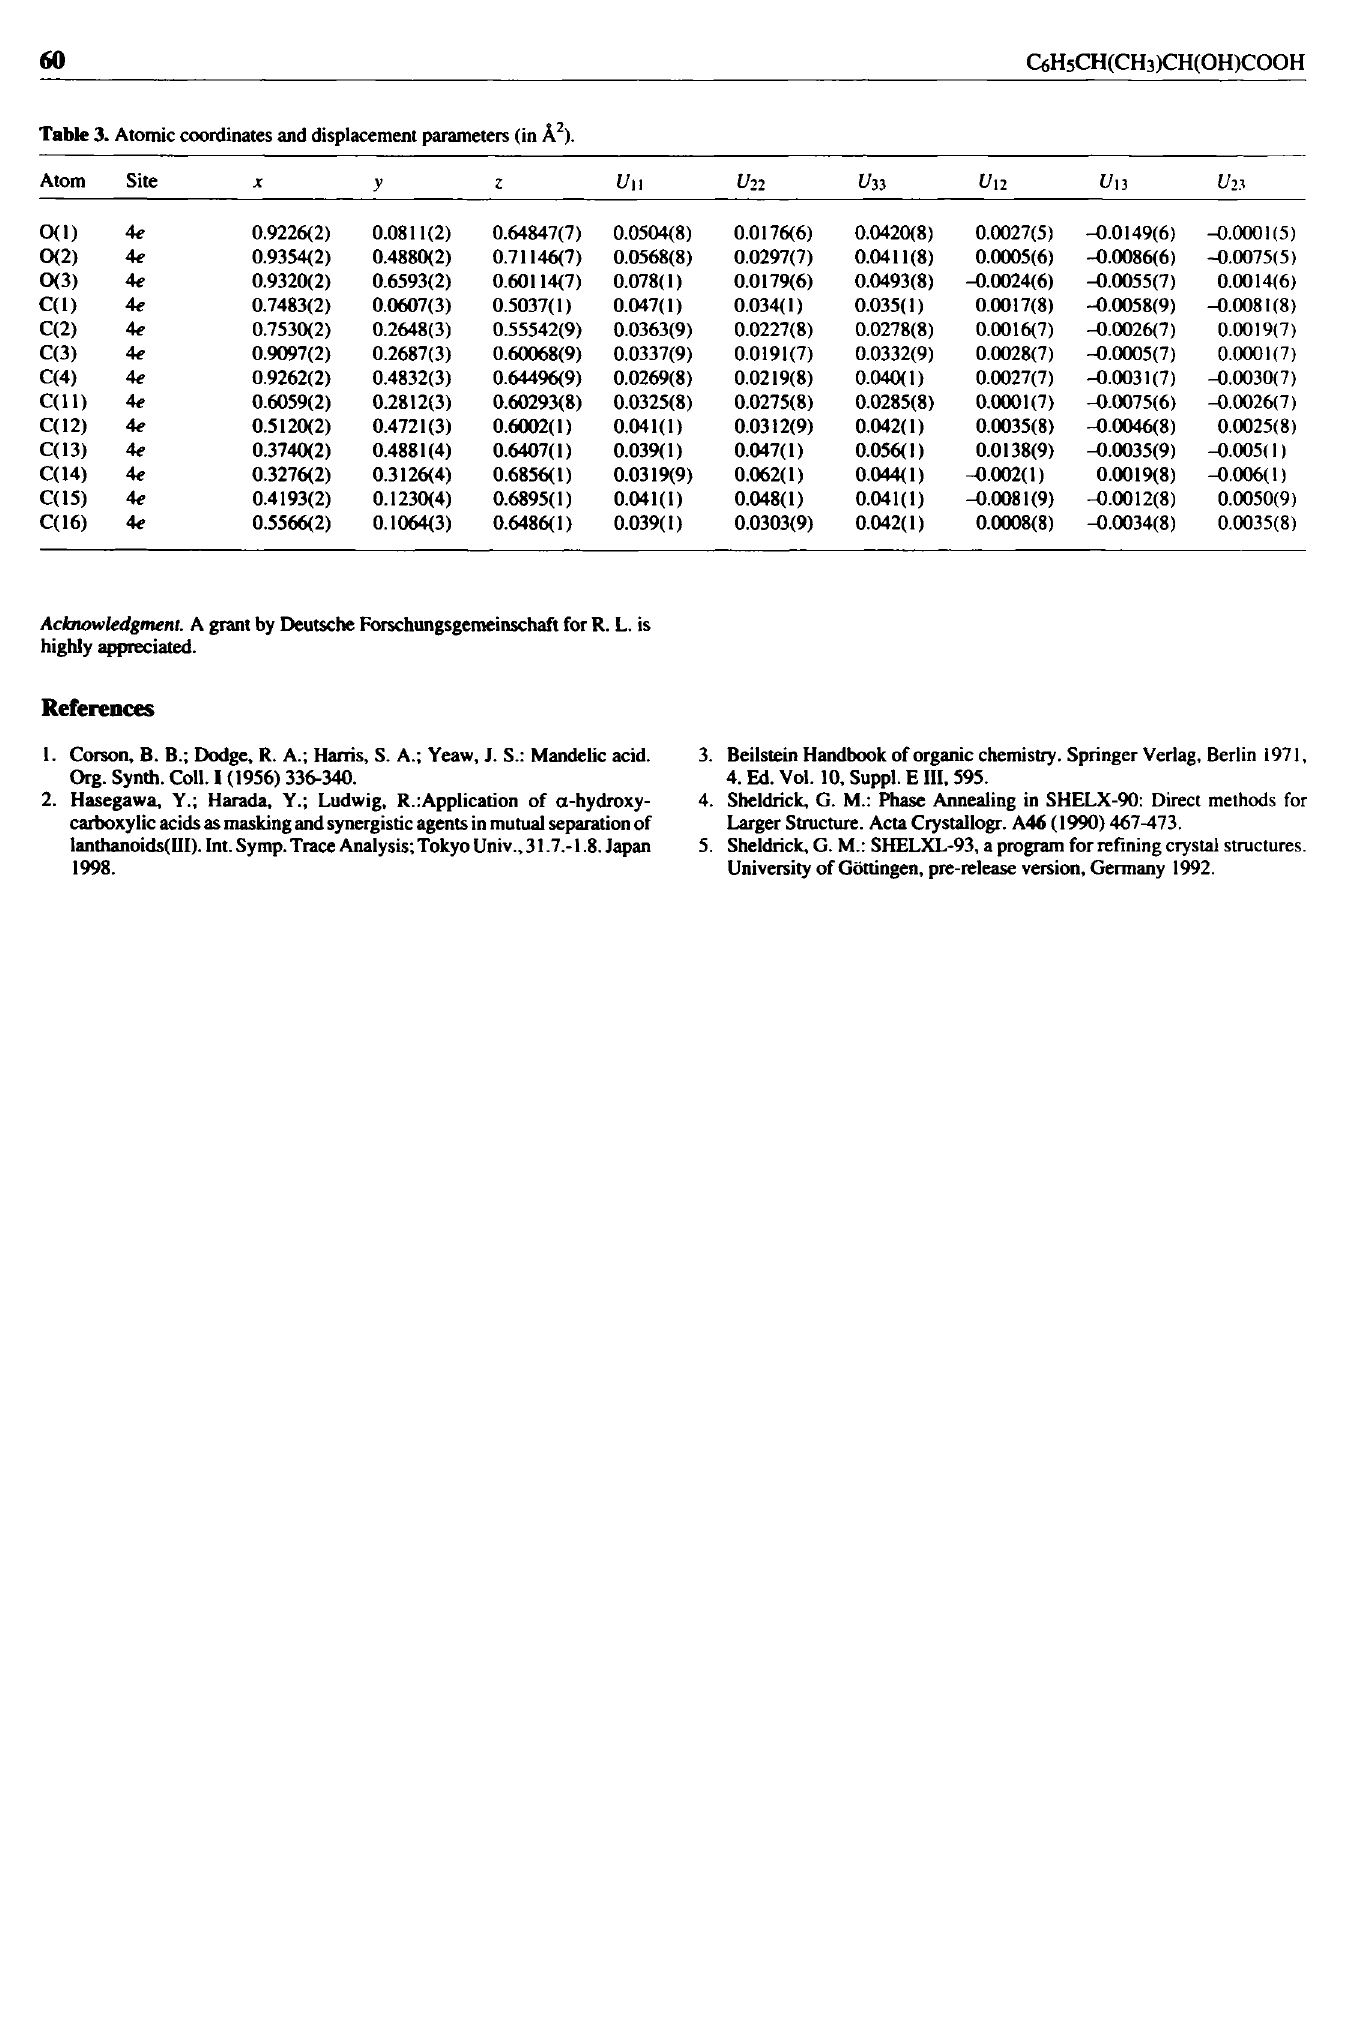
Table 3. Atomic coordinates and displacement parameters (in Â 2